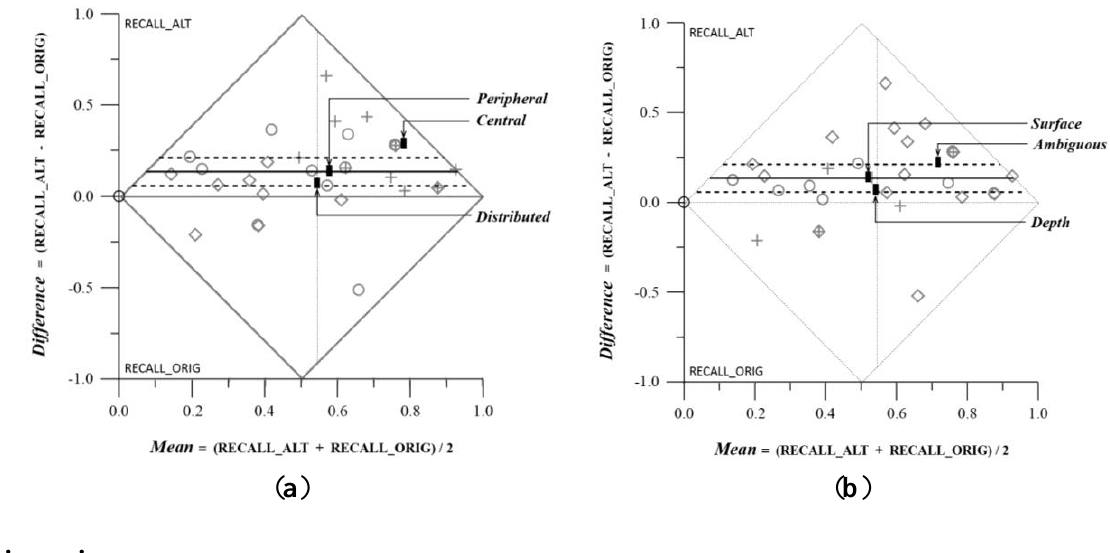
Figure 7. Matched Pairs Comparison on Memory Exercise: Recalls in Original versus Altered Drawings. ( a ) Grouped by Attentional Focus; ( b ) Grouped by Plastic